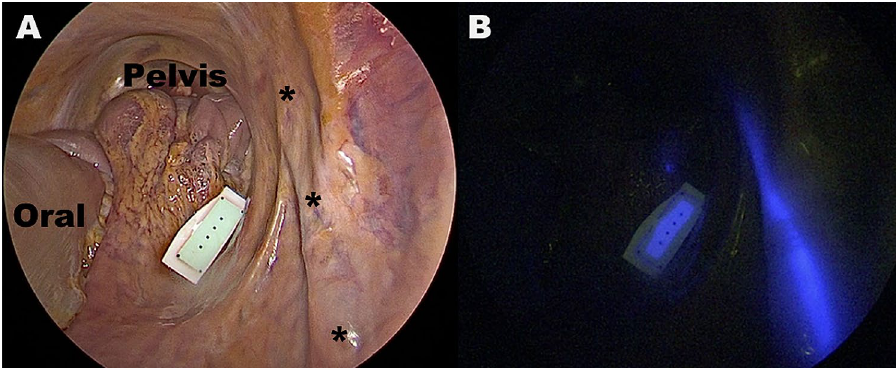
Figure 5. Demonstration of the efficiency of the NICE-coated catheter in detecting the undissected ureter under near-infrared light ( B ) in the human